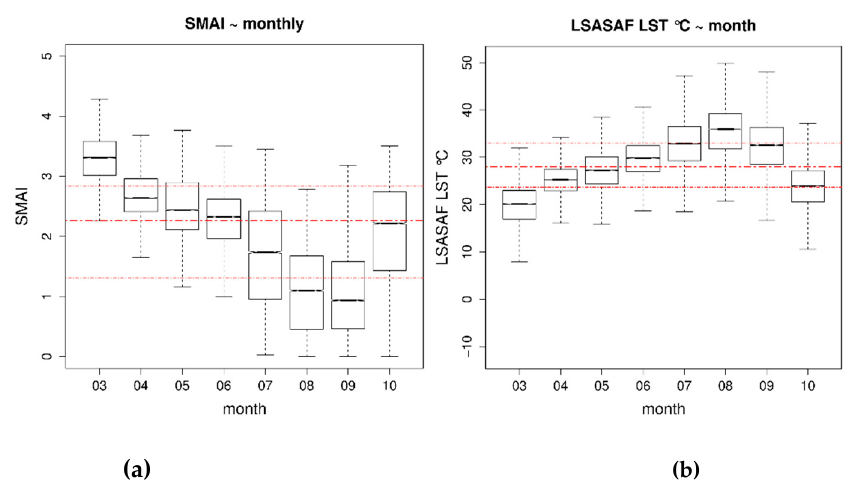
Figure 3. Boxplots of monthly mean values (2007–2018) for the region of Bulgaria during the growing season (March–October) of ( a ) SMAI; ( b ) LSASAF LST 0900 UTC C. The boxes represent the interquartile range (25th to 75th percentile, first and third red line), whiskers cover 99.3% of the data, and the middle (red) lines represent the mean values.